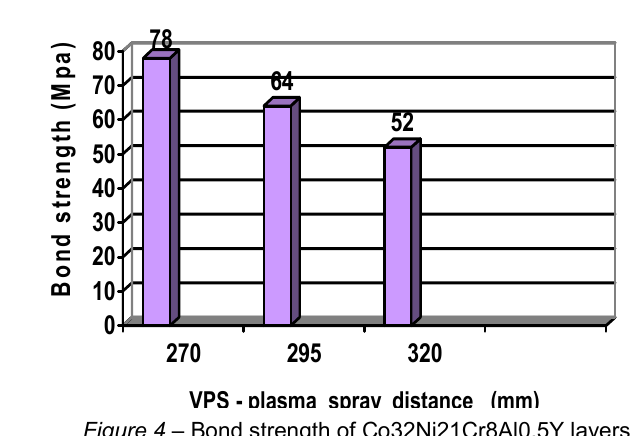
Figure 4 – Bond strength of Co32Ni21Cr8Al0.5Y layers Slika 4 – Č vrsto ć a spoja Co32Ni21Cr8Al0.5Y